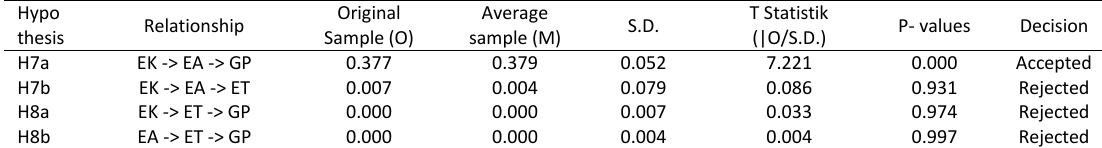
Table 5: Structural model assesment (indirect effect result and decision)